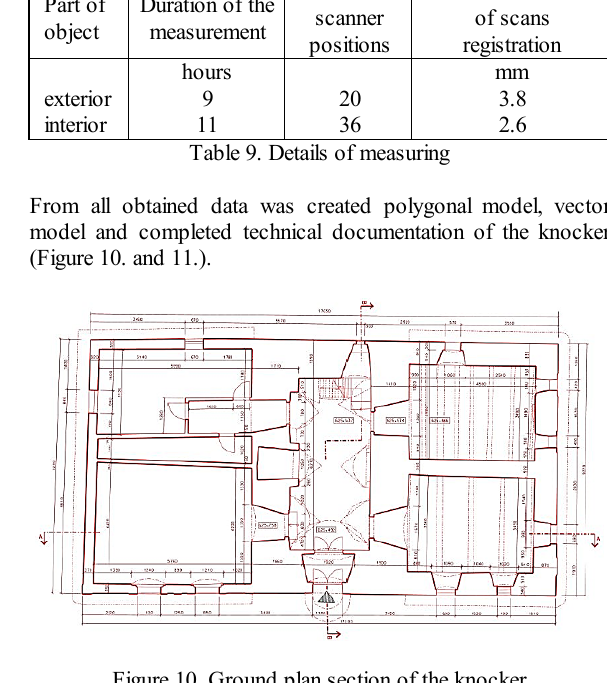
Figure 10. Ground plan section of the knocker